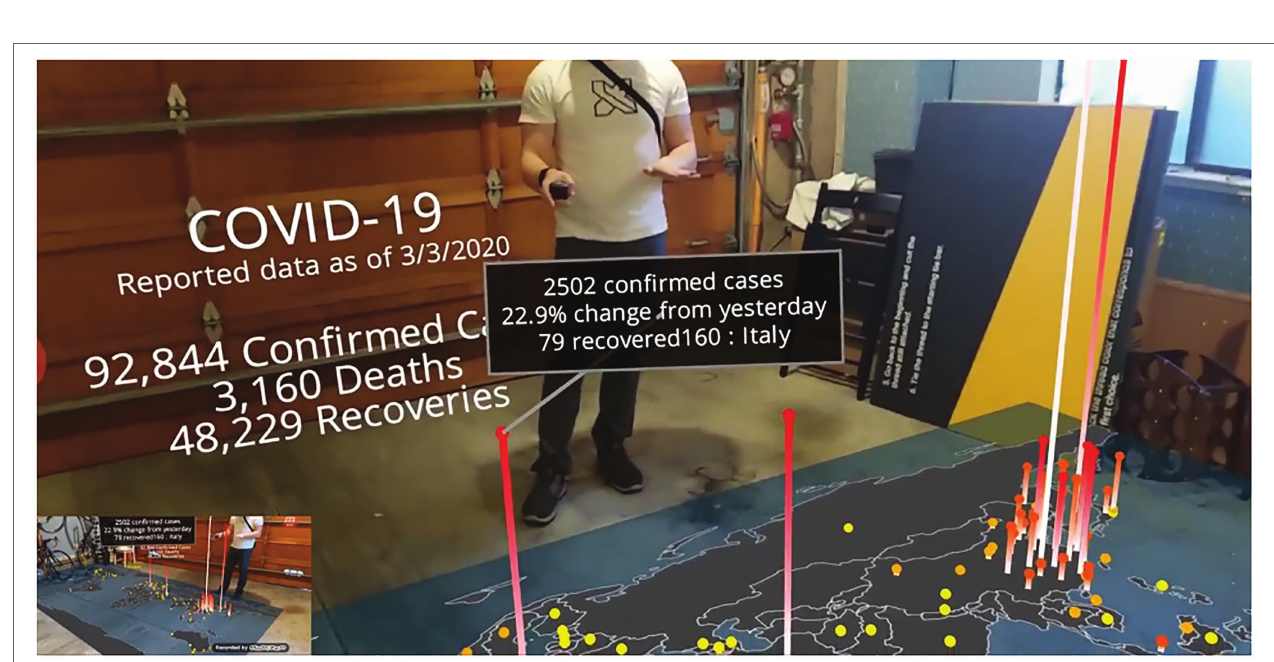
FIGURE 4 | A snapshot from the AR Presentation showing Covid-19 early March 2020 cases geospatially on an AR map. Height of spike corresponds to confirmed cases.